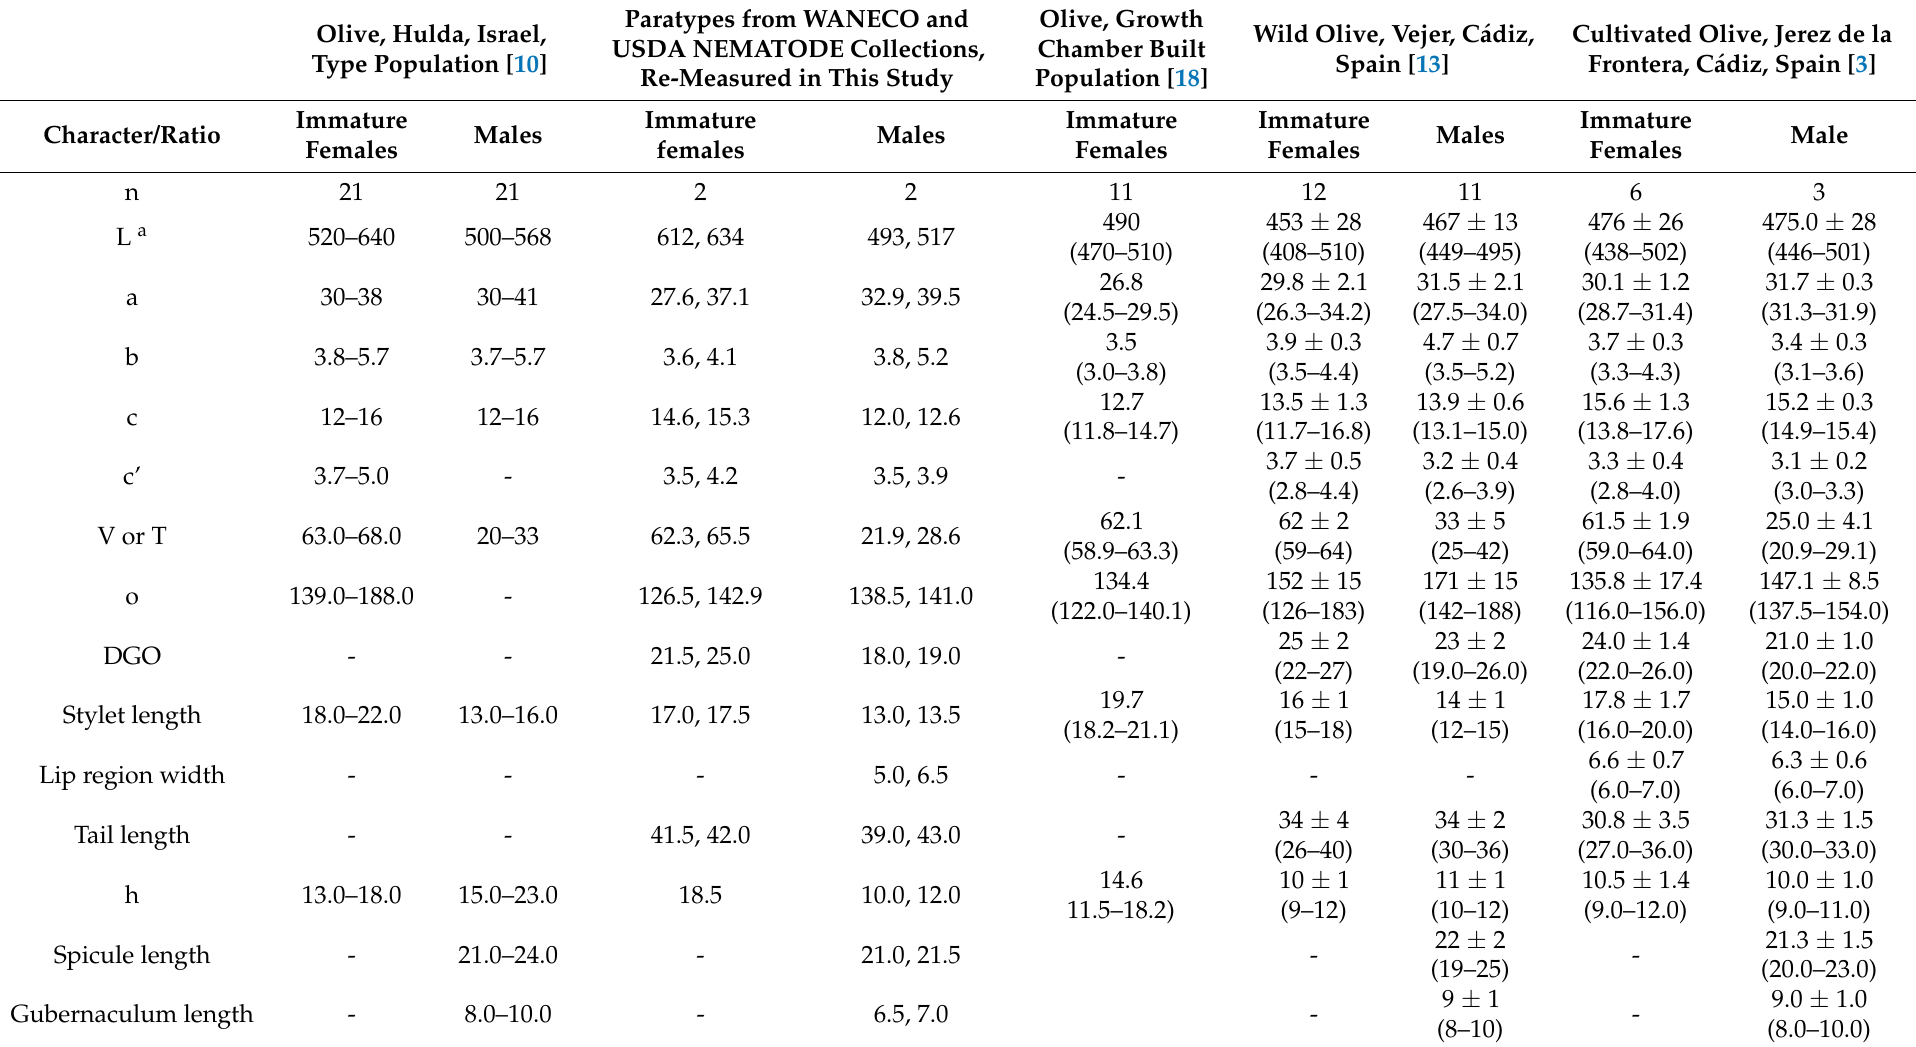
Table 5. Measurements of immature females and males of Rotylenchulus borealis (= R. macrosoma) from type locality in Israel and several localities in Spain. All measurements are in micrometers and in the form mean ± SD